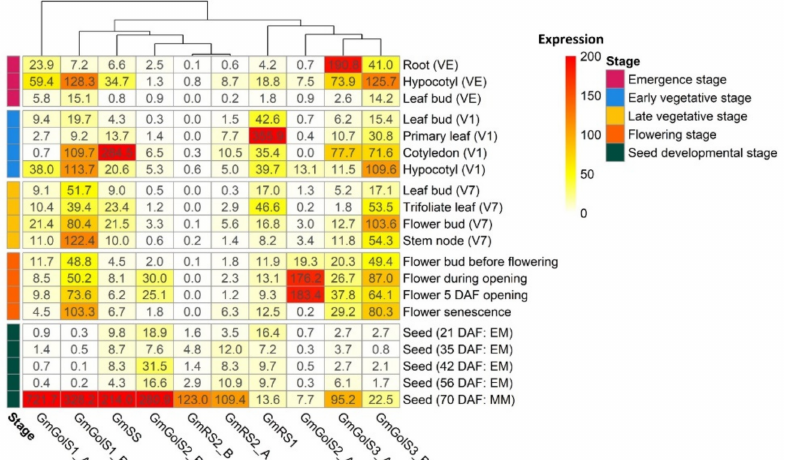
Figure 3. Heatmap of the normalized expression values (TPM) of the galactinol synthase ( GmGolS1-3 ), raffinose synthase ( GmRS1-2 ) and stachyose synthase ( GmSS ) genes in various plant tissues during different developmental stages in G. max cv. Wm82 (SRP038111). The rows represent plant tissues in five different developmental stages: emergence stage, early vegetative stage, late vegetative stage, flowering stage and seed developmental stage. More detailed information of the exact growth stage of the tissues can be found after the tissues names between brackets, with growth stage abbreviations (VE: emergence stage; V1: first-node stage; V7: seventh-node stage; EM: early maturation stage of the seed; MM: mid maturation stage of the seed; DAF: days after flowering) adapted from Fehr et al. [55]. The columns represent the different genes and their expression levels, represented with a color gradient in which white indicates no expression (0 TPM) and red the highest expression (200+ TPM). Hierarchical clustering was performed between the columns to obtain gene